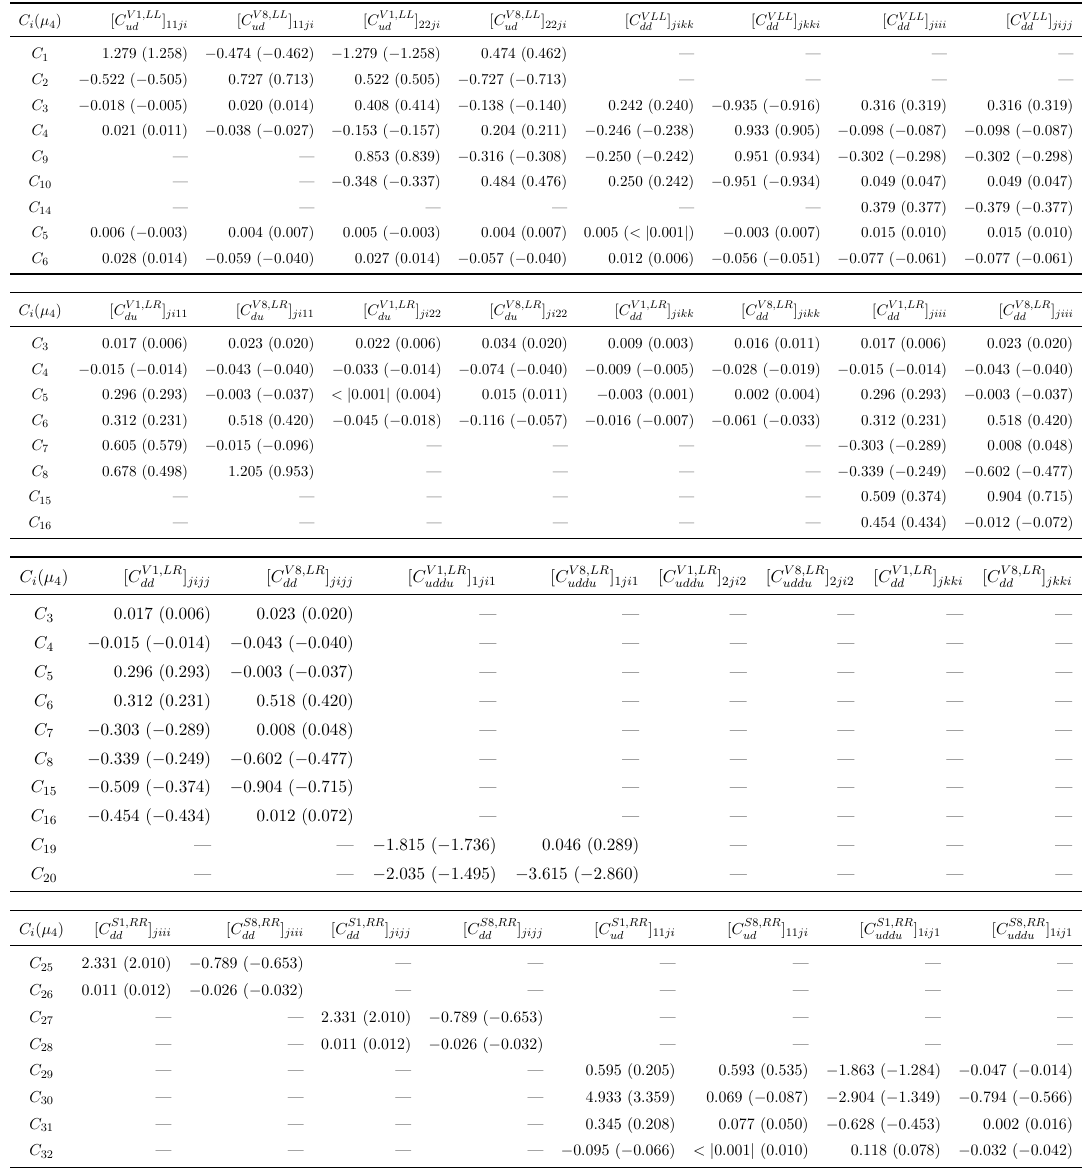
Table 3 . The elements u ab ( µ had , µ ew ) of the NLO (LO) RG evolution operator in eq. (6.12) for N f = 3 at µ had . They connect the JMS Wilson coefficients at µ ew = 160 GeV to the BMU ones at µ had = µ 4 = 1 . 3